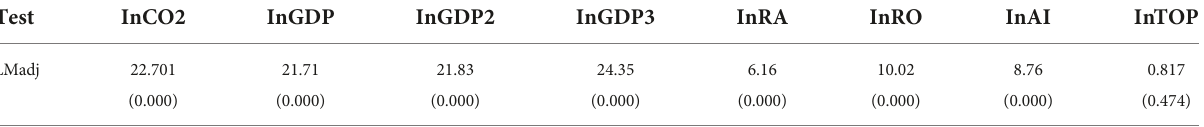
TABLE 2 Result of cross sectional dependence test.